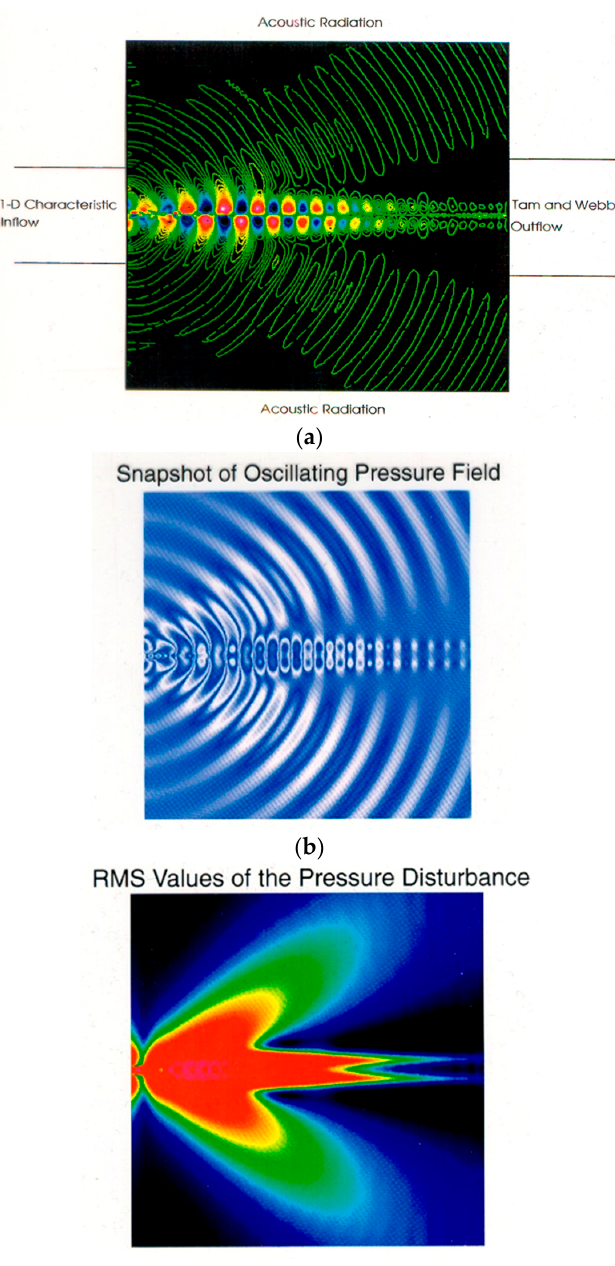
Figure 15. Prediction of the unsteady flow and acoustics of a supersonic jet using Linearized Euler Equations (Ref. [58,61]). ( a ) Boundary treatments, ( b ) Snapshot of the oscillating pressure field, and ( c ) root mean square of the acoustic pressure distribution.